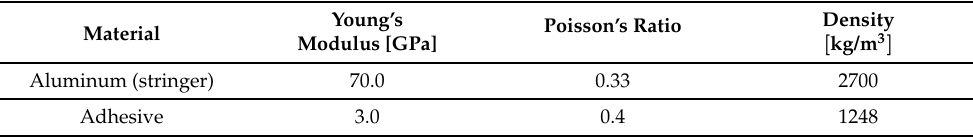
Table 4. Material properties of the stringer and